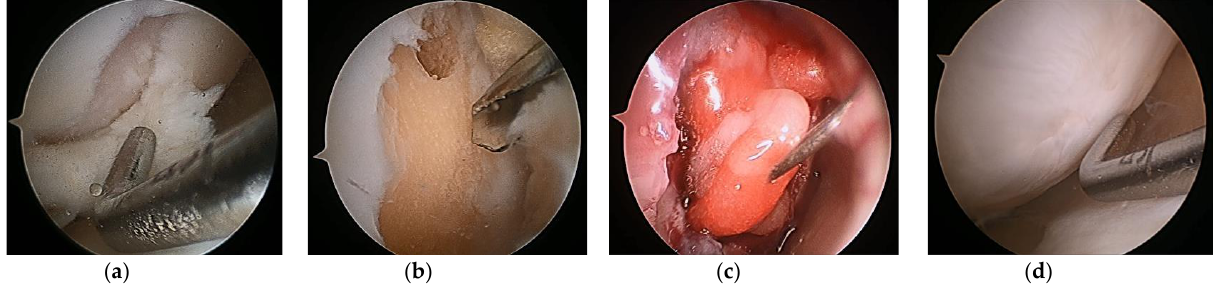
Figure 10. ( a ) Cartilage defect, ( b ) defect preparation and multiple drilling, ( c ) collagen gel injection